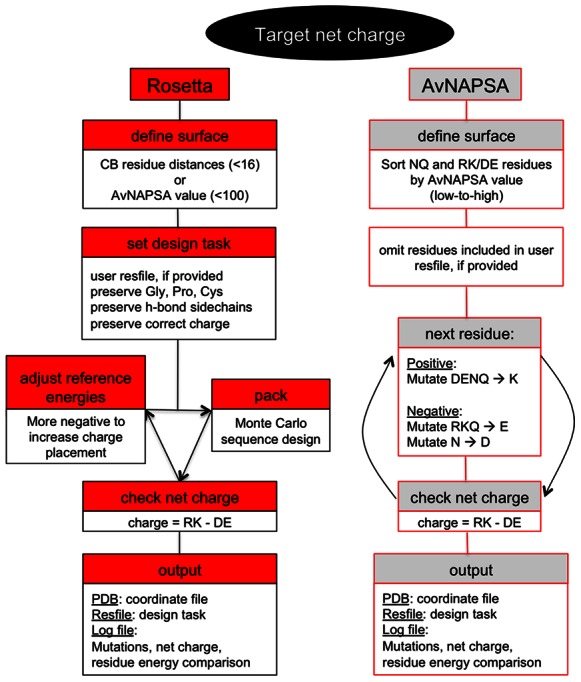
Workflow of two protocols for supercharging protein surfaces.Both protocols begin by defining the surface of the protein of interest, and if provided, reading a residue file that specifies residues to not mutate. AvNAPSA forcibly mutates NQ and DE/RK in order of solvent accessibility. Rosetta uses Monte Carlo side chain placement guided by computed energies to mutate any surface residue except G, P, C, and hydrogen-bonded side chains, and charged-residue reference energies are adjusted to vary net charge. Both protocols are set up to achieve a desired net charge (above), or to specified reference energies (Rosetta) or surface cutoff (AvNAPSA). Output includes the PDB coordinate file of the redesigned protein, the residue file specifying the allowed mutations, and a log file with information such as residues mutated, number of mutations, net charge, residue energies, and a PyMOL selection command to conveniently view the mutations.